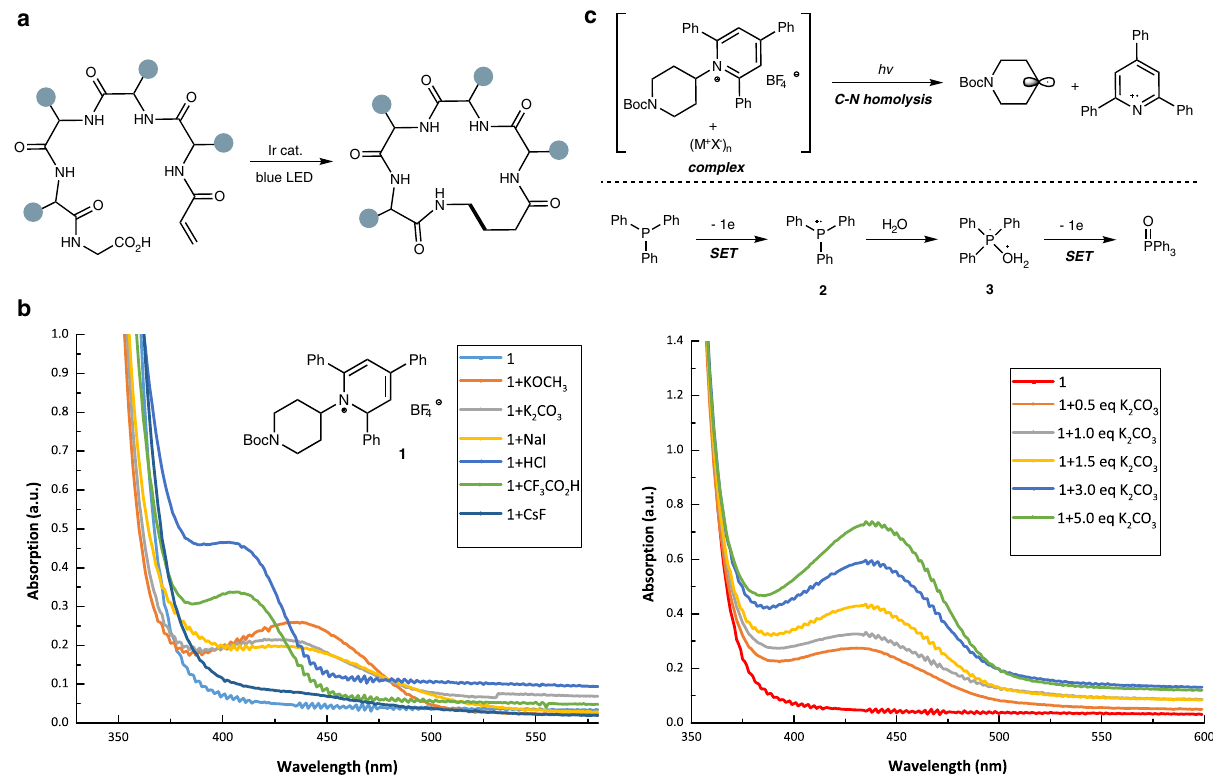
Fig. 1 Design plan. a Photoredox decarboxylative macrocyclization. b UV-Vis absorption spectrum of 1 with ionic compounds. c Visible light induced ionic compound promoted homolytic fragmentation of pyridinium C – N